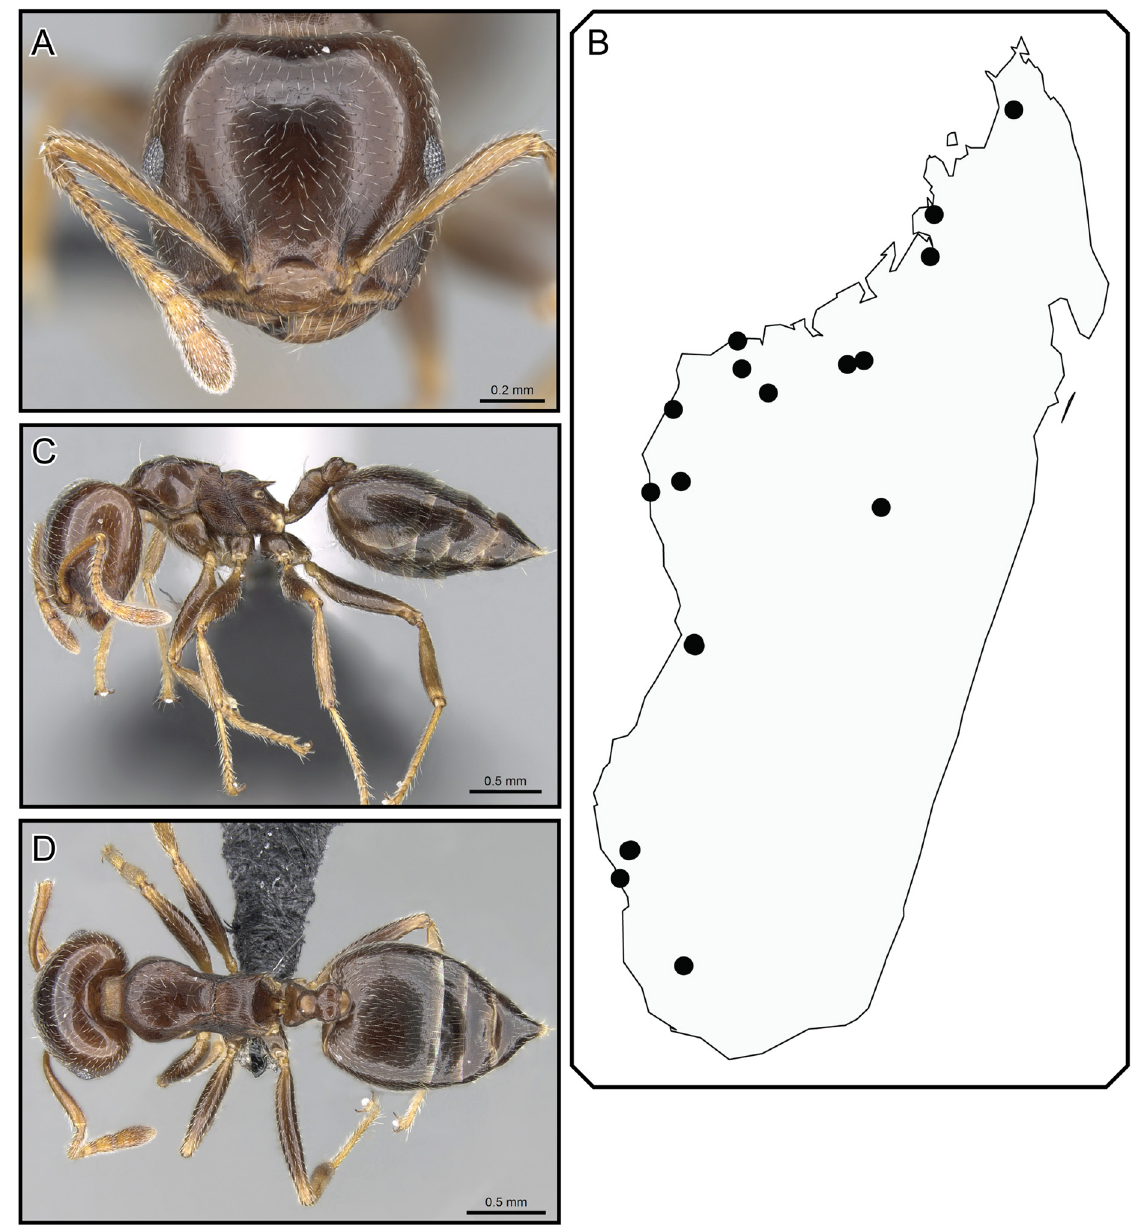
Fig. 19. Crematogaster ramamy sp. nov., worker and distribution. A, C-D. Worker (CASENT0317780). A. Full-face. C. Profile. D. Dorsal. B. Species